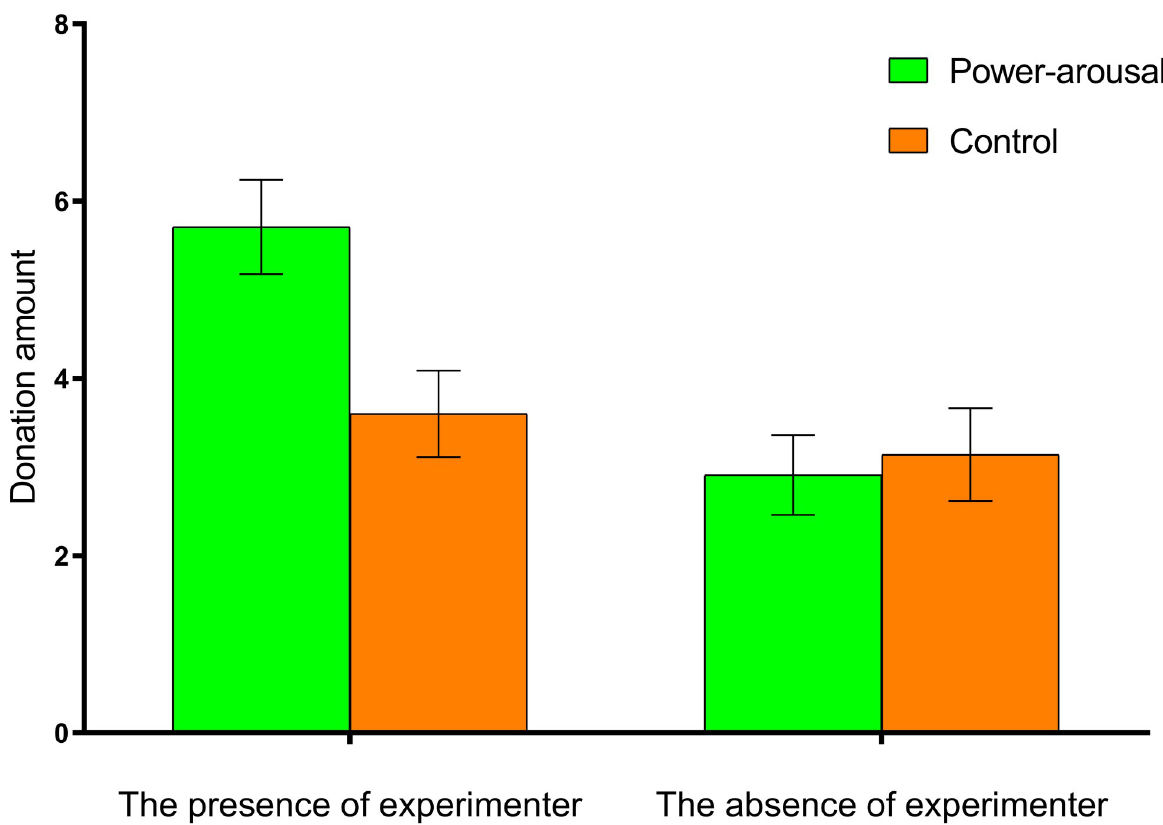
Fig 1. Charitable donation as a function of power motivation and social